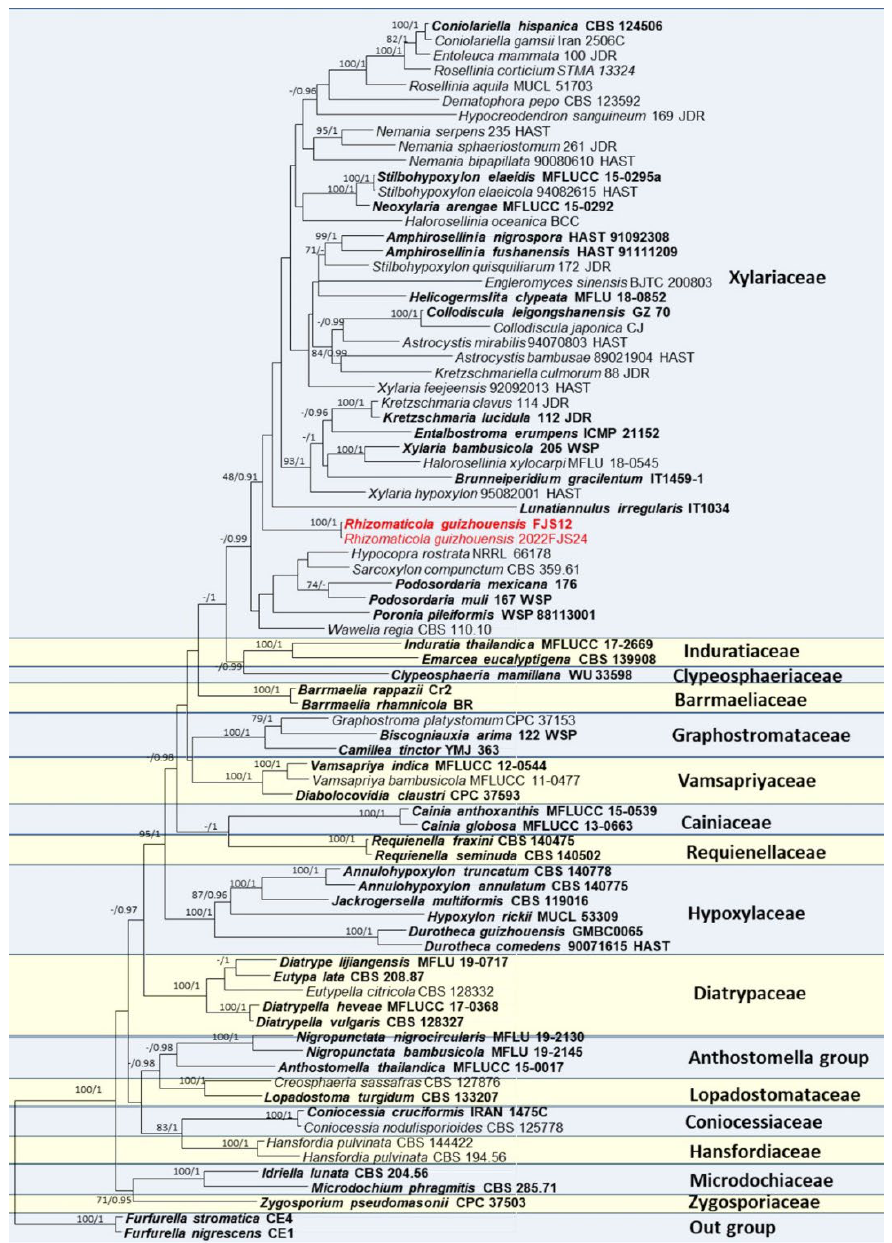
Figure 1. Phylogeny of Xylariales obtained from a Maximum Likelihood analysis of the combined ITS, LSU, rpb 2 and tub 2 using RAxML-HPC BlackBox software online. Furfurella nigrescens (CE1) and F. stromatica (CE4) were taken as outgroup taxa. Strains or specimen numbers were followed by their names. Type and authority strains are marked in bold. Bayesian posterior probabilities ≥ 0.95 and bootstrap support values for maximum likelihood (ML) higher than ≥ 70% are marked above the nodes; an en-dash (“-”) indicates a value < 0.95 (PP) or <70%